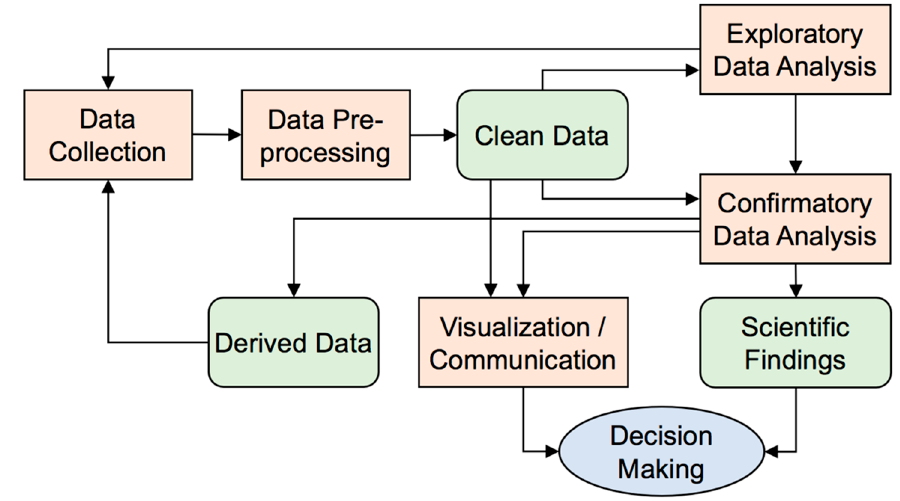
Figure 1. Key steps in a data science process (adapted from [3]).